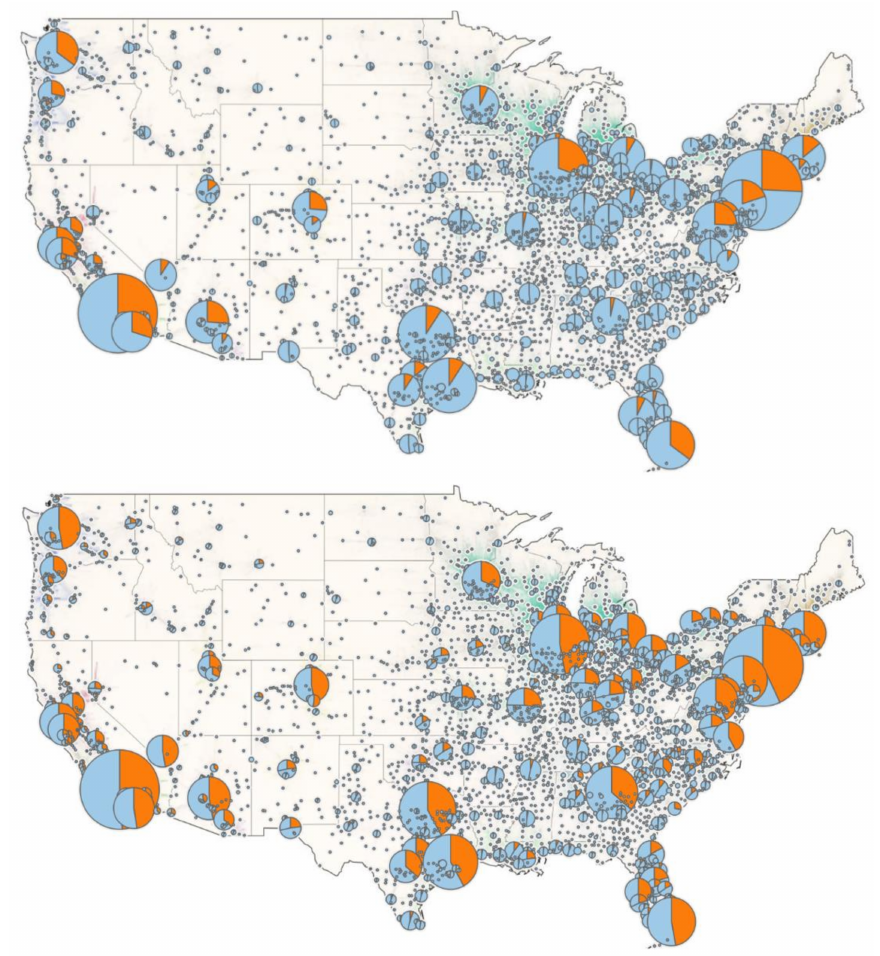
Figure 6. FCEV sales in 2050 by urban area in the Urban Markets scenario ( top ) and National Expansion scenario ( bottom ). The total size of the pies indicates total LDV sales, the orange slices represent FCEV sales, and the blue slices include all other